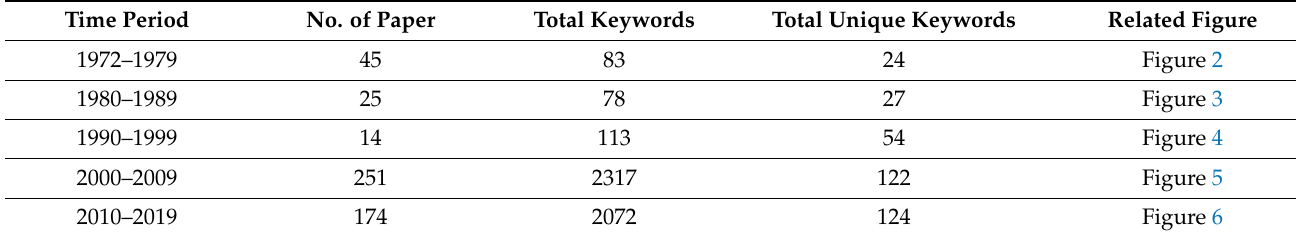
Table A3. Summary of keyword co-occurrence